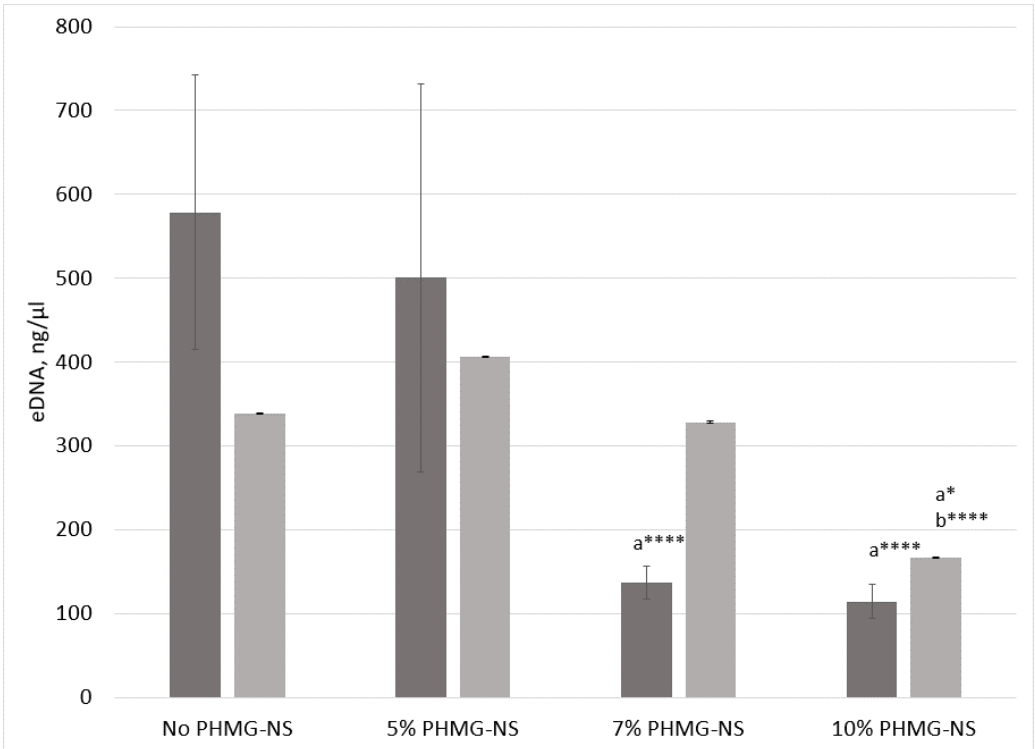
Figure 6. Amount of eDNA precipitated from a biofilm layer (solid-bottom phase) of 72-h-old biofilm-formed K12 (dark grey) and ATCC 25923 (light grey) cultures with PA-11 films containing 5%, 7% and 10% of PHMG-NS. a, statistical significance compared to control (No PHMG-NS); b: statistical significance compared to 5% PHMG-NS. * p < 0.05 **** p < 0.001.